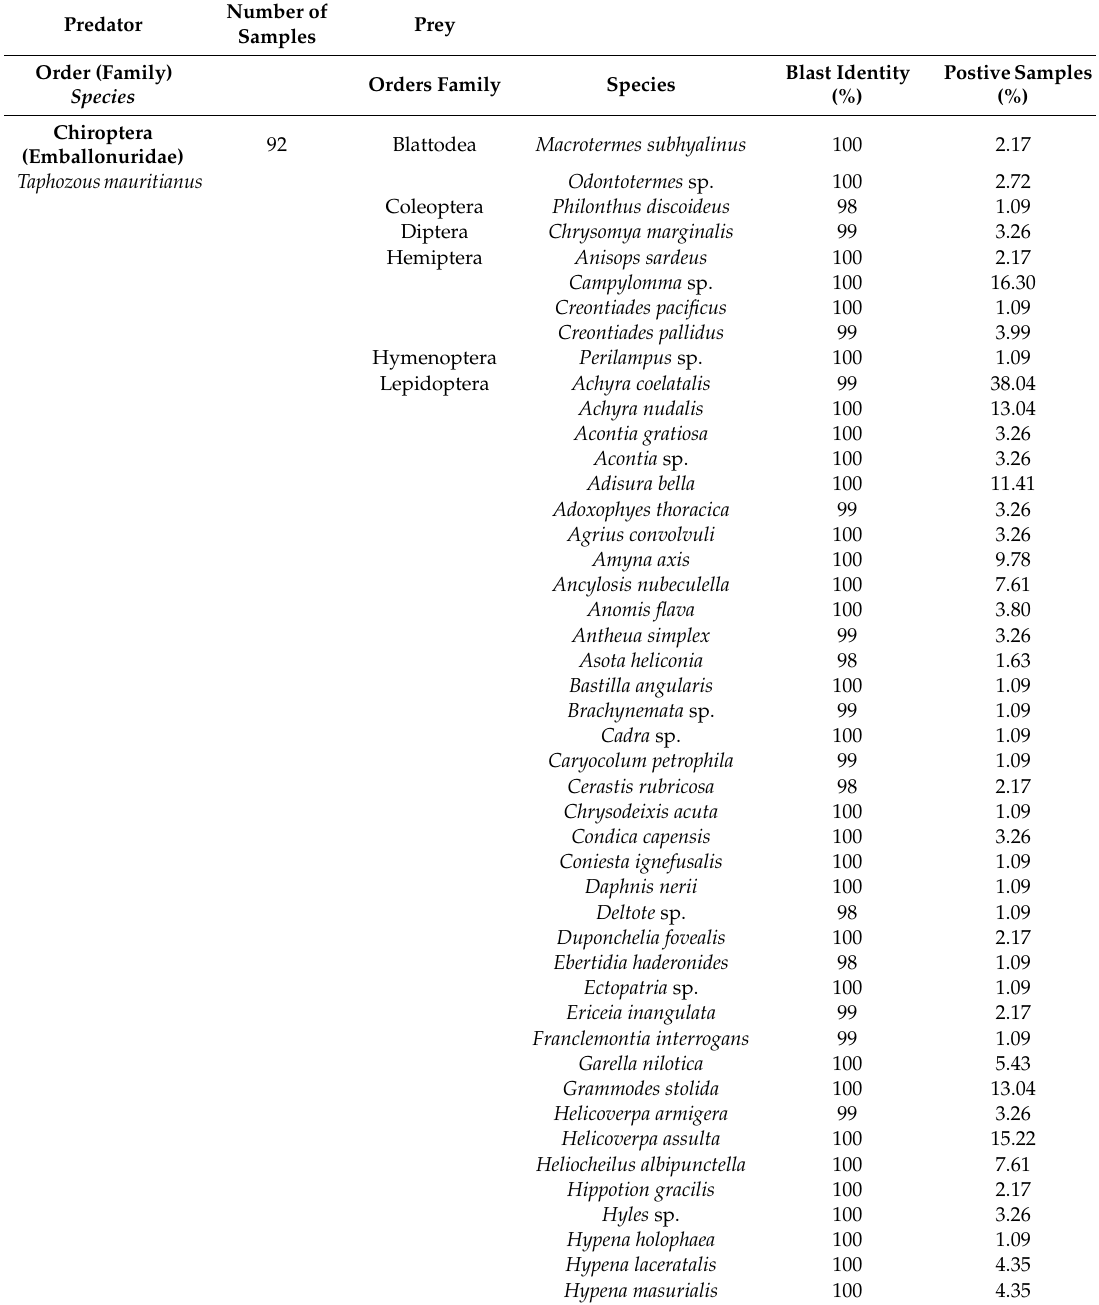
Table 2. Taxa and number of positive samples of prey species detected in feces of two major insectivorous vertebrates collected in the surrounding environment of millet fields in